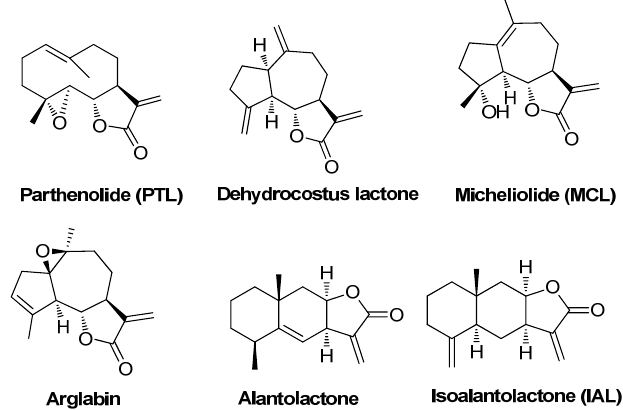
Figure 1. Structures of some natural sesquiterpene